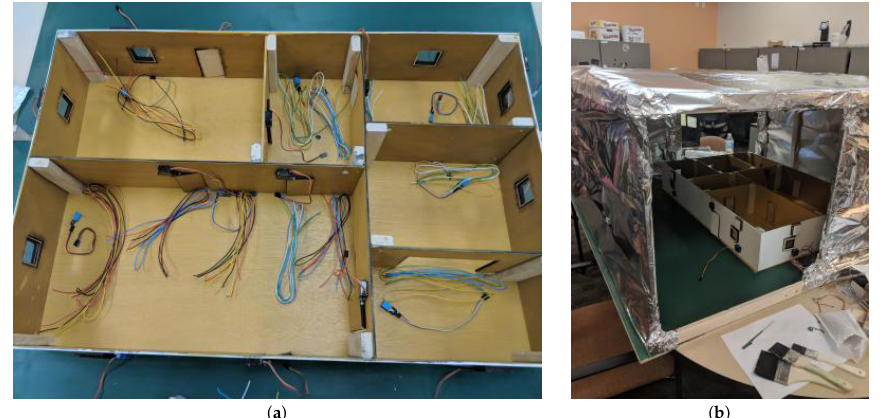
Figure 1. ( a ) The layout of the ScaledHome-2 testbed. ( b ) The testbed in the environmental